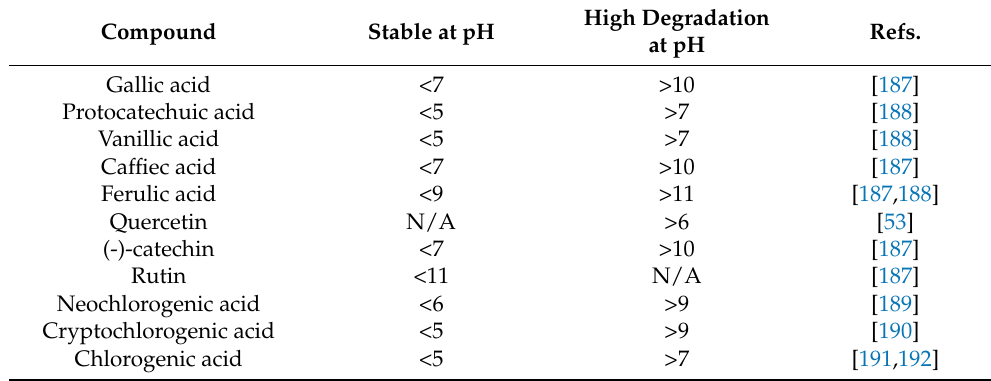
Cryptochlorogenic acid Chlorogenic